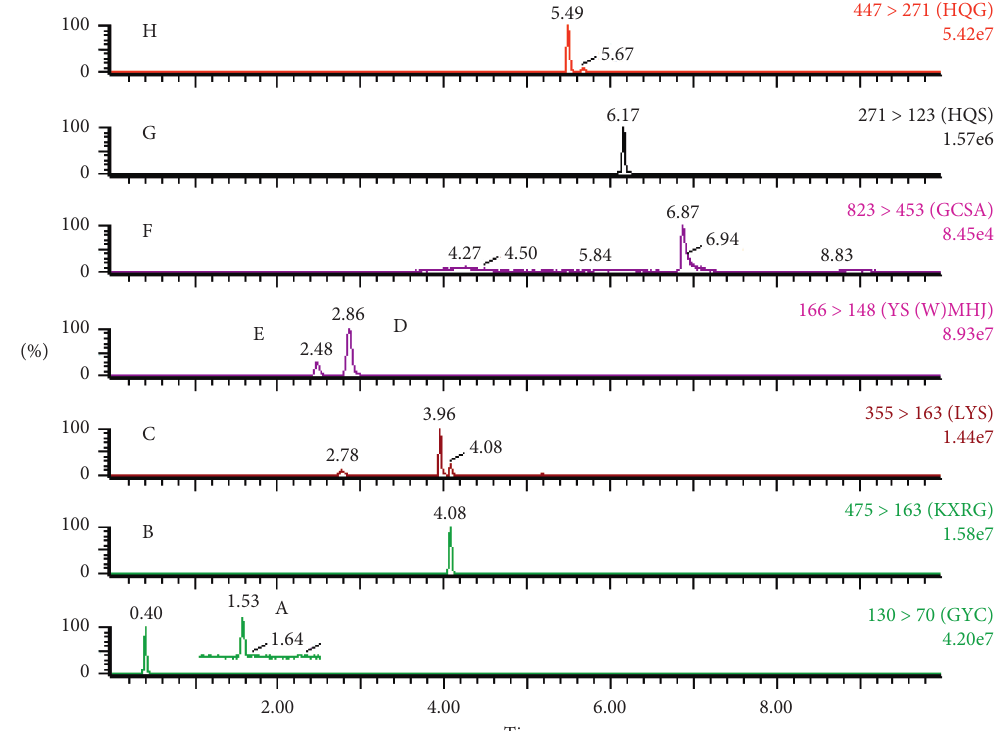
Figure 3: Typical UPLC-MS/MS analysis MRM chromatograms of the sample solution: A (R, S)-goitrin, B amygdalin, C chlorogenic acid, D pseudoephedrine hydrochloride, E ephedrine hydrochloride, F ammonium glycyrrhizinate, G baicalein, and H